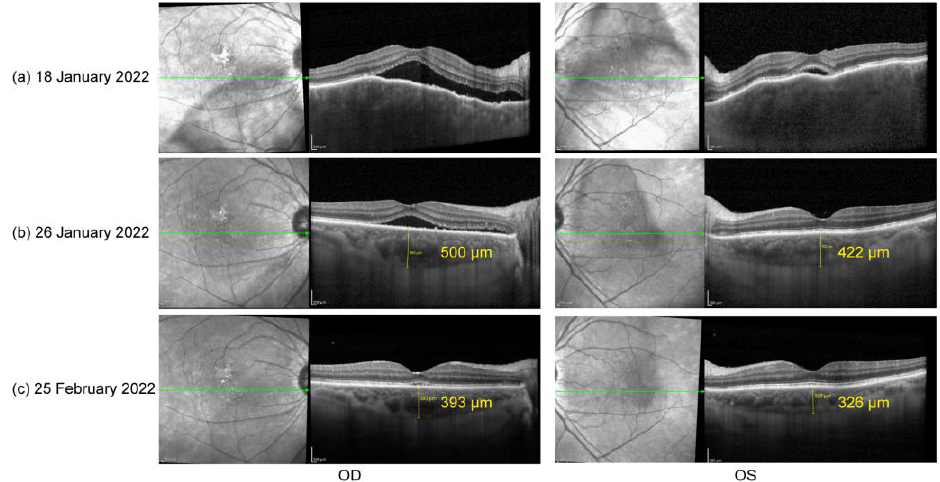
Figure 1. ( a ) Optical coherence tomography (OCT) on 18 January 2022: serous retinal detachment (SRD) and choroidal thickening OU; ( b ) OCT on 26 January 2022: significant reduction in subretinal fluid and relief of choroid edema OU; ( c ) OCT on 25 February 2022: little subretinal fluid in OD and a total recover of retinal structure in OS.